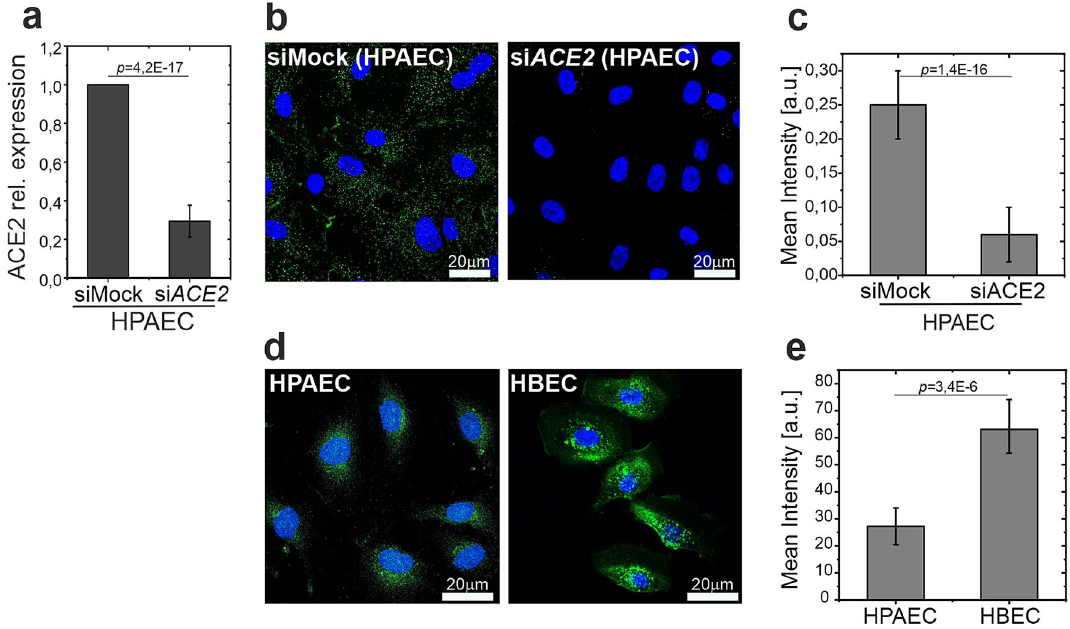
Figure 1. Examination of the presence of ACE2 in human ECs. ( a ) Expression of ACE2 in siMock and si ACE2- transfected HPAECs. ( b , c ) Immunofluorescent staining of HPAECs transfected with ACE2-targeting (si ACE2 ) and non-targeting (siMock) siRNA, with anti-ACE2 antibody. Representative photographs and quantitative analysis of immunofluorescence intensity. ( d , e ) Immunofluorescent staining of ACE2 in HPAECs and HBECs. Representative photographs and quantitative analysis of immunofluorescence intensity. Statistics: p values were determined by one-way ANOVA followed by Tukey’s post-hoc test. Figure created with OriginPro2021 (https:// www. origi nlab. com/ 2021) and ImageJ 1.53e (https:// imagej. nih. gov/